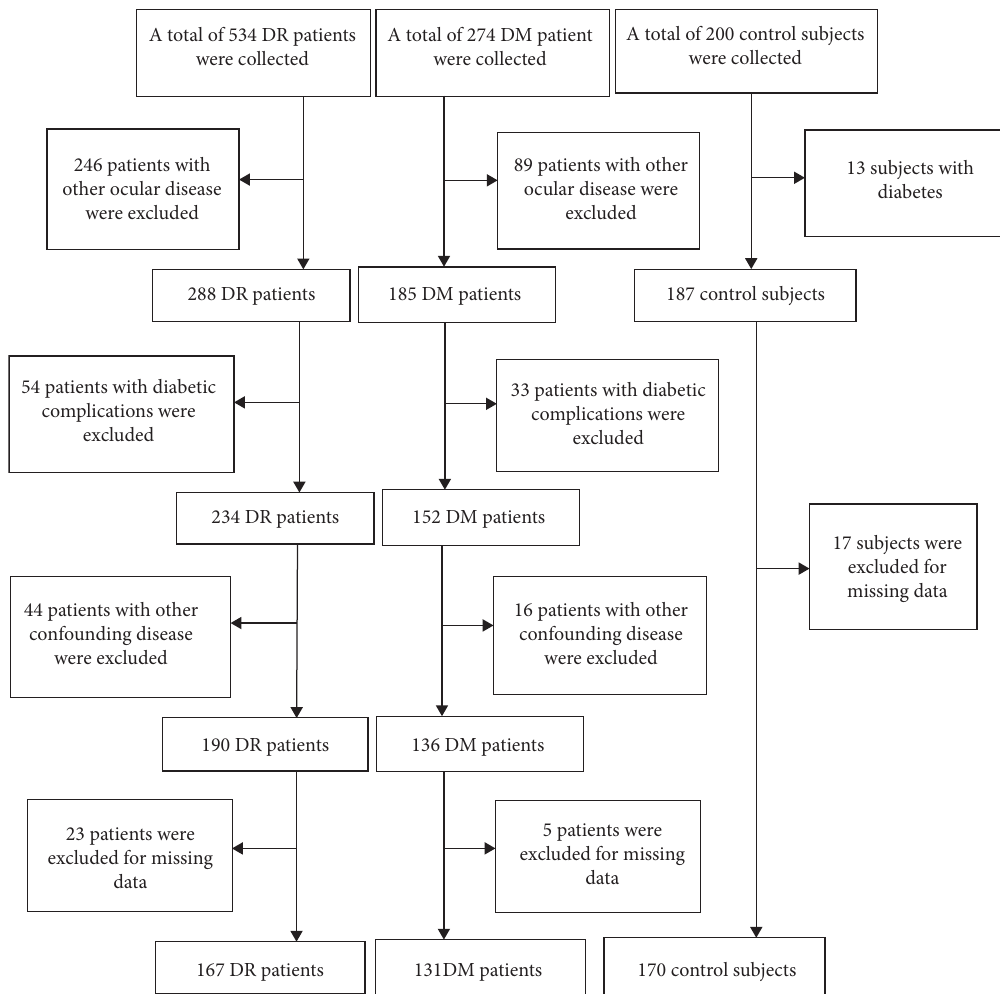
Figure 1: The study population flow